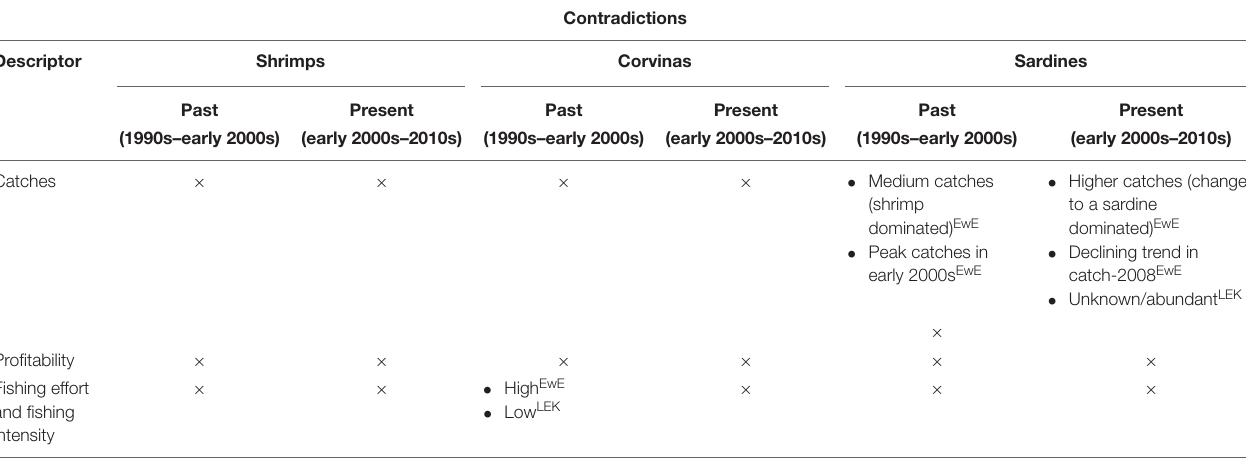
TABLE 3 | Contradictions across two systems, LEK (this study) and scientific knowledge (EwE; Alms and Wolff,